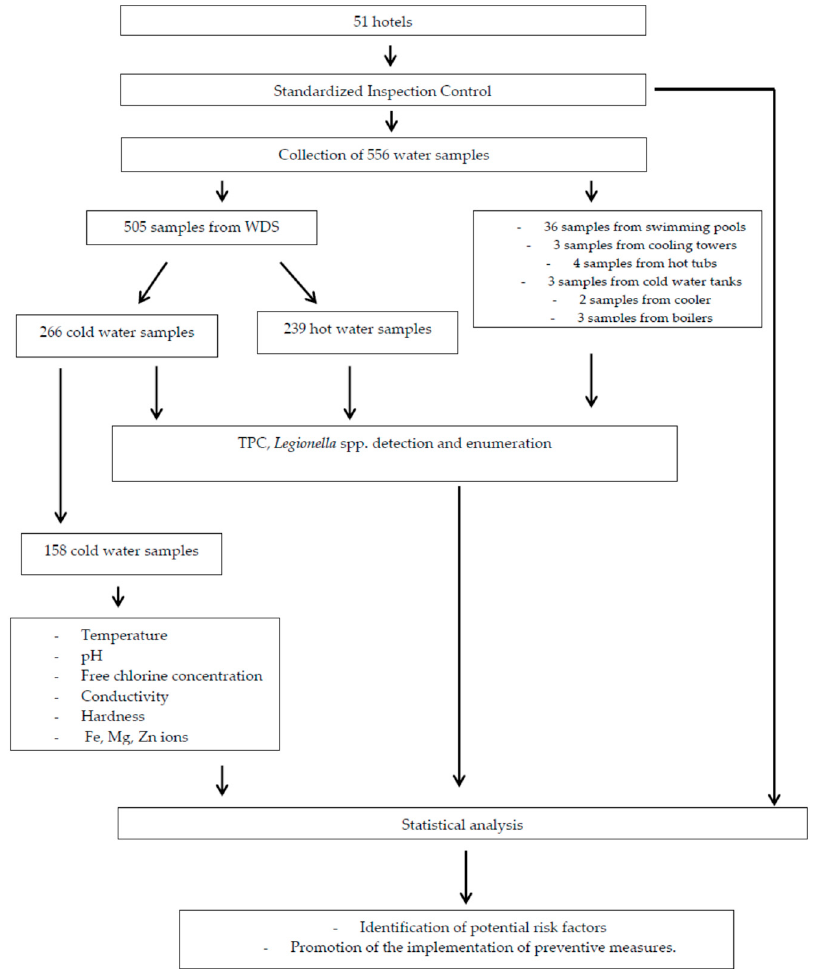
Figure 1. Flowchart of the methodology used for the study. WDS: Water Distribution System; TPC: Total Plate Count .